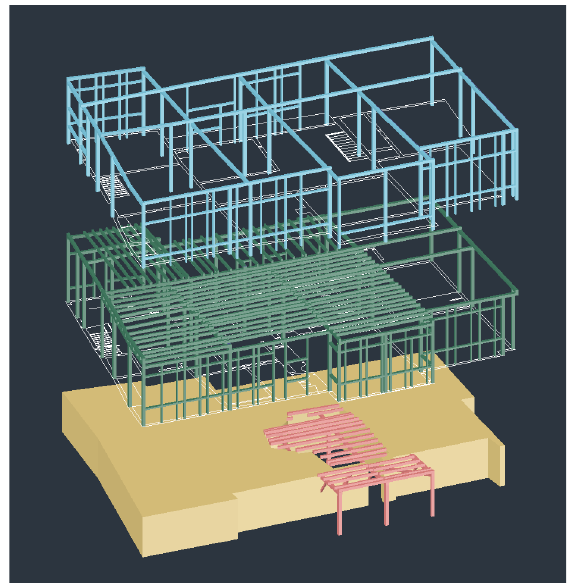
Figure 8. Timber Frame